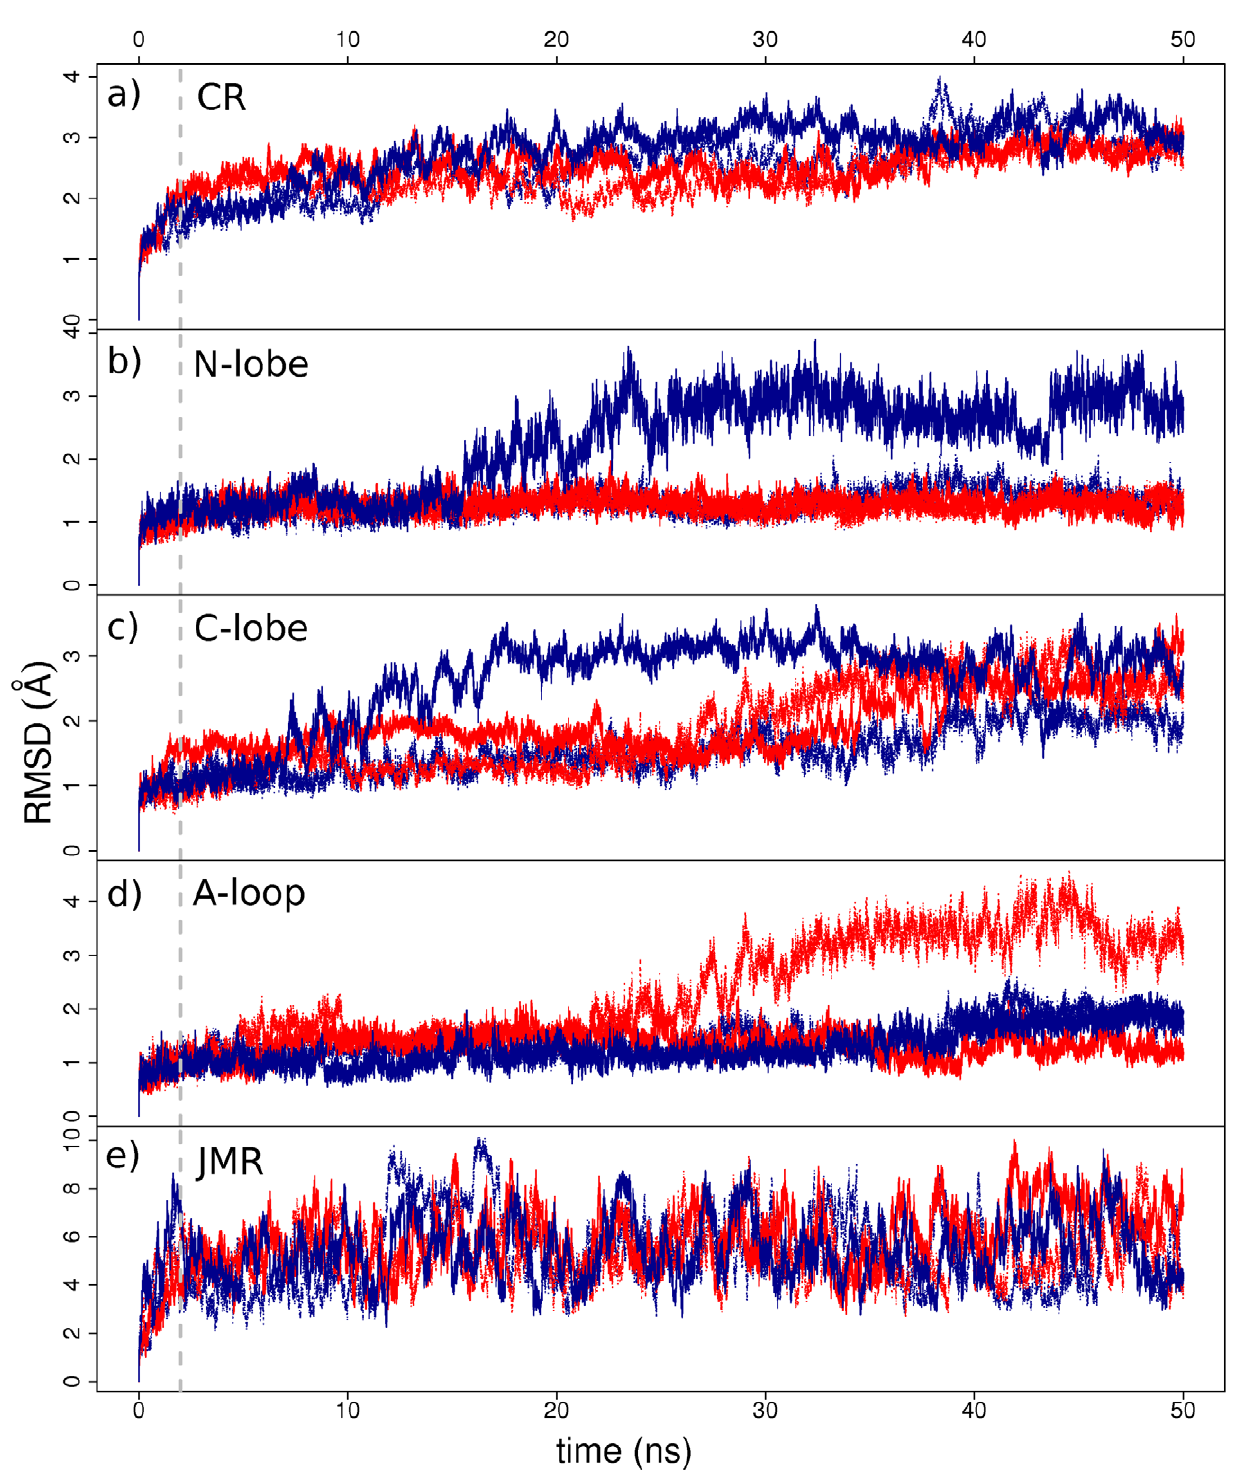
Figure 2. MD simulations of KIT cytoplasmic region in the auto-inhibited inactive form. The RMS deviations (in A˚) were calculated from MD simulations of full-length CR for wild-type KIT, WT 547-935 (in blue), and D816V mutant, MU 547-935 (in red), on the backbone atoms of ( a ) the whole CR, ( b ) N-lobe, ( c ) C-lobe, ( d ) A-loop and ( e ) JMR. The 50-ns simulations 1 and 2 of the wild-type (mutant, respectively) are shown by plain and dashed lines. The dashed grey vertical line drawn at 2 ns indicates the relaxation time.